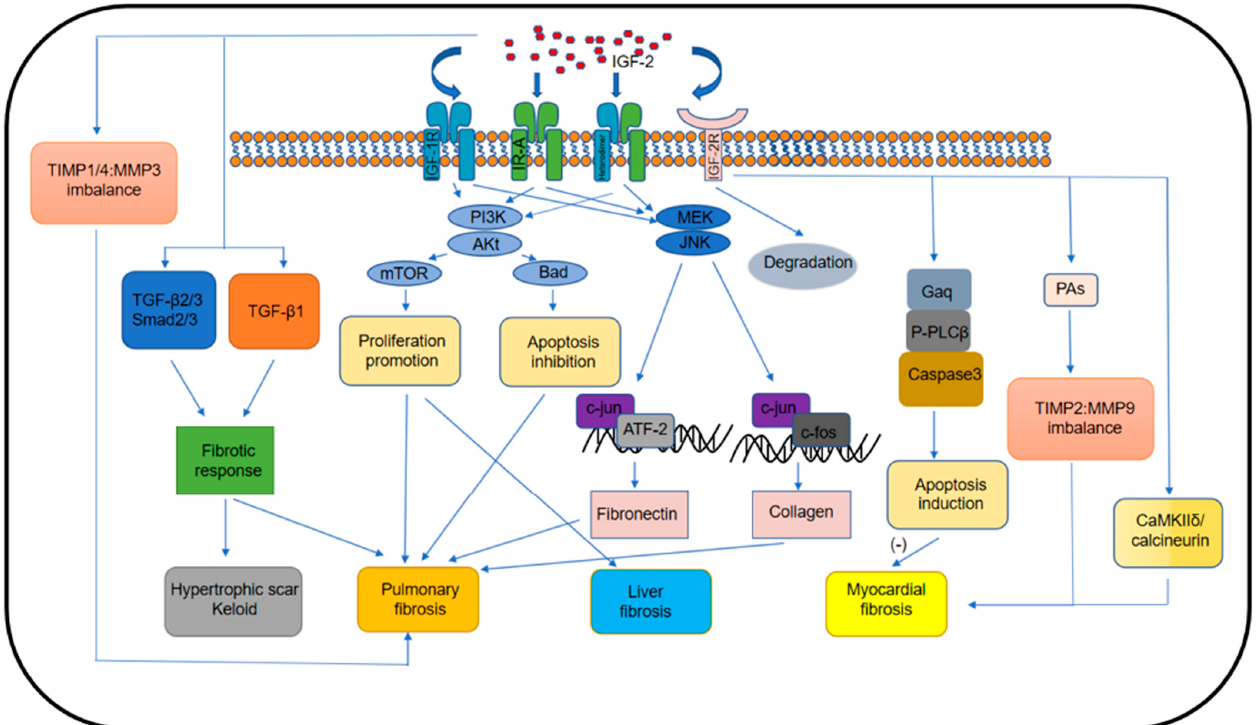
Figure 1. Molecular pathways of IGF-2 promotes organ fibrosis. By binding to IGF-1R, IR, and their heterodimers, IGF-2 actives the PI3K/Akt and JNK/c-jun signaling pathways to promote fibroblast proliferation, inhibit their apoptosis, and increase extracellular matrix (fibronectin and collagen) synthesis. IGF2 can also promote organ fibrosis by disrupting the TIMP/MMP balance and activating CaMKII δ and calcineurin, as well as TGF- β signaling.